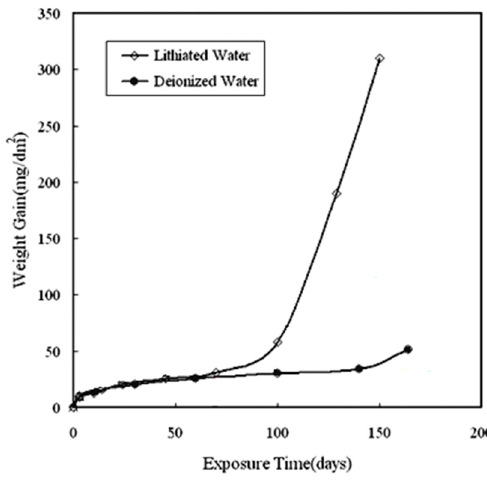
Figure 1. Weight gain versus exposure time for the Zircaloy-4 specimens corroded in lithiated water with 0.01 M LiOH and deionized water at 633 K/18.6 MPa.